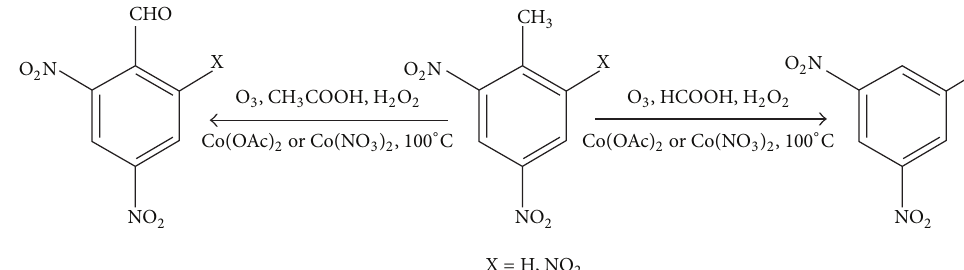
Figure 1: Synthesis route of DNT and TNT oxidation. Only the major product is